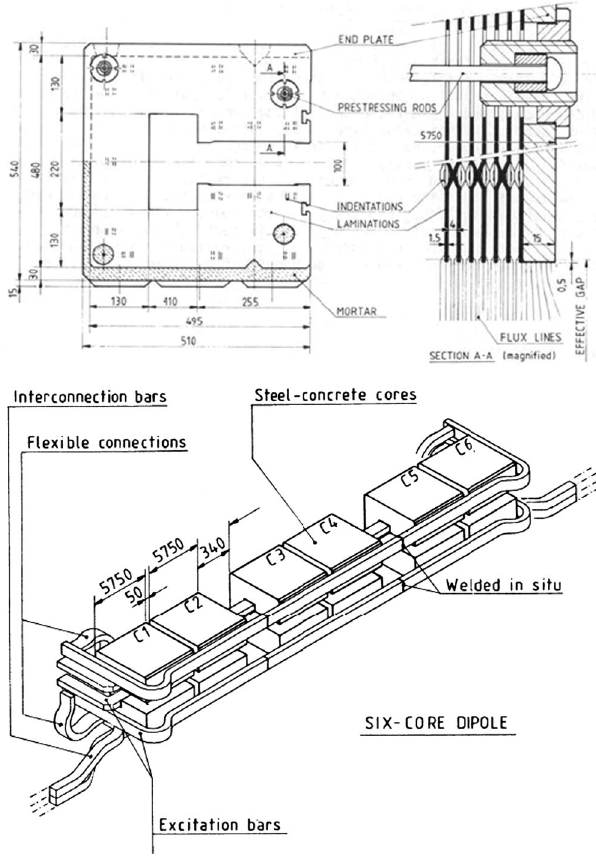
FIG. 1. Cross section and 3D sketch of the LEP dipoles.